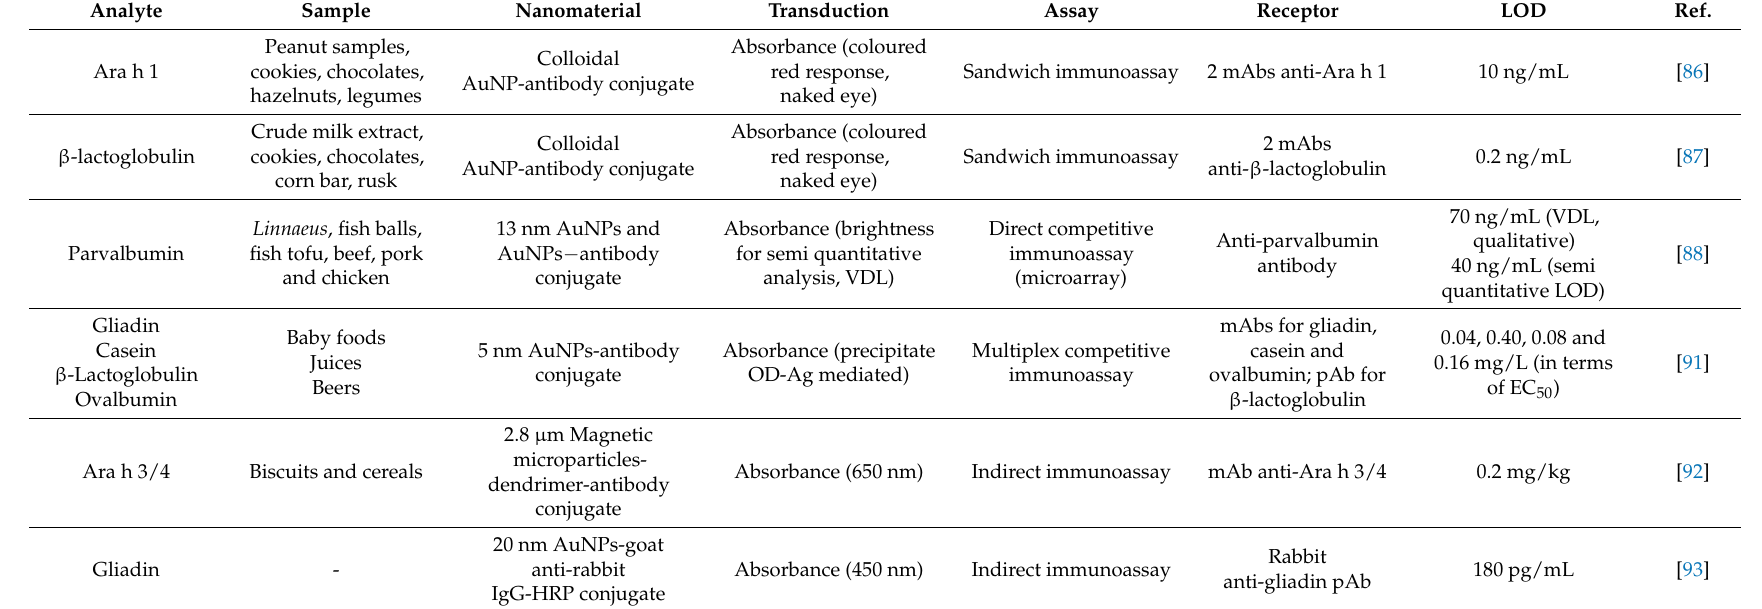
Table 5. Colorimetric nanoparticle-based assays for the detection of food